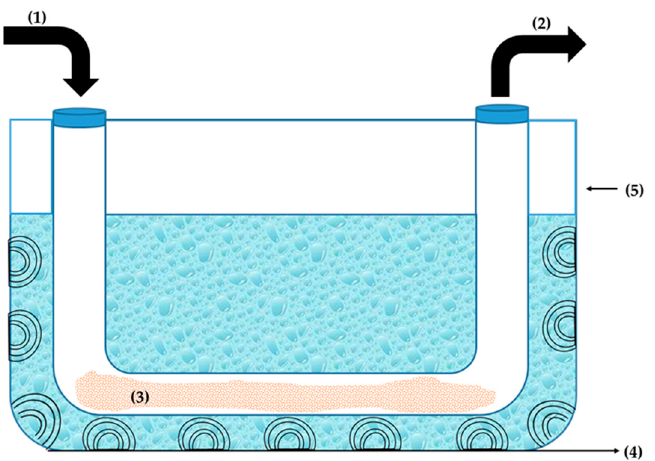
Figure 7. Scheme of the experimental setup for continuous biodiesel production under ultrasonic activation. (1)—Inlet; (2)—outlet; (3)—matrix; (4)—ultrasonic transducer; (5)—ultrasonic bath.